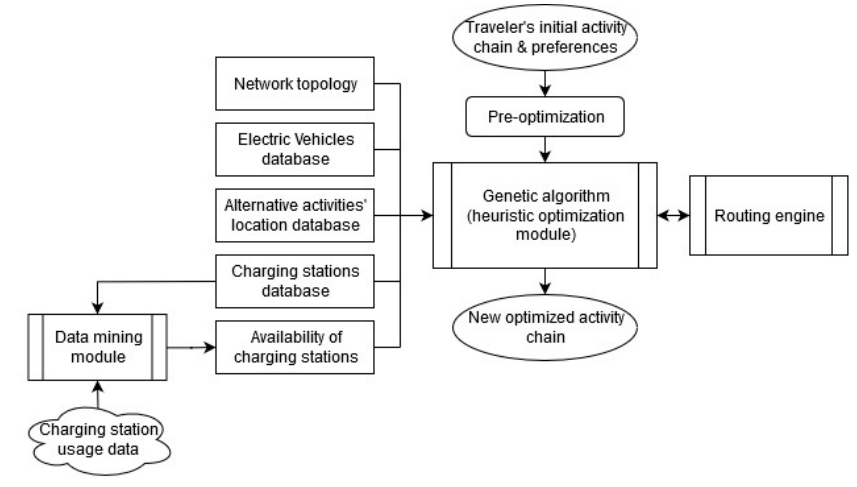
Figure 3. The method elaborated.